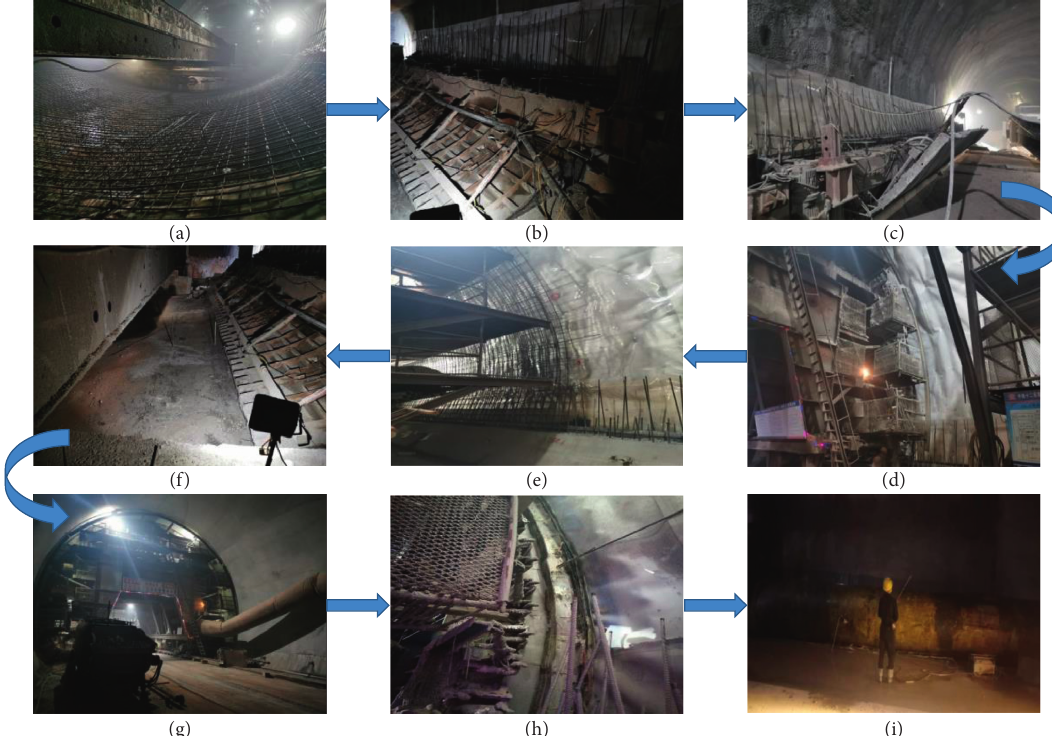
Figure 3: Process drawing of secondary lining: (a) tying of reinforcement, (b) clamping of secondary lining back arch, (c) pouring of secondary lining back arch, (d) pouring of road surface, (e) tying of ring reinforcement, (f) ring clamping, (g) pumping of concrete, (h) ring dismantling of mold, and (i) maintenance.